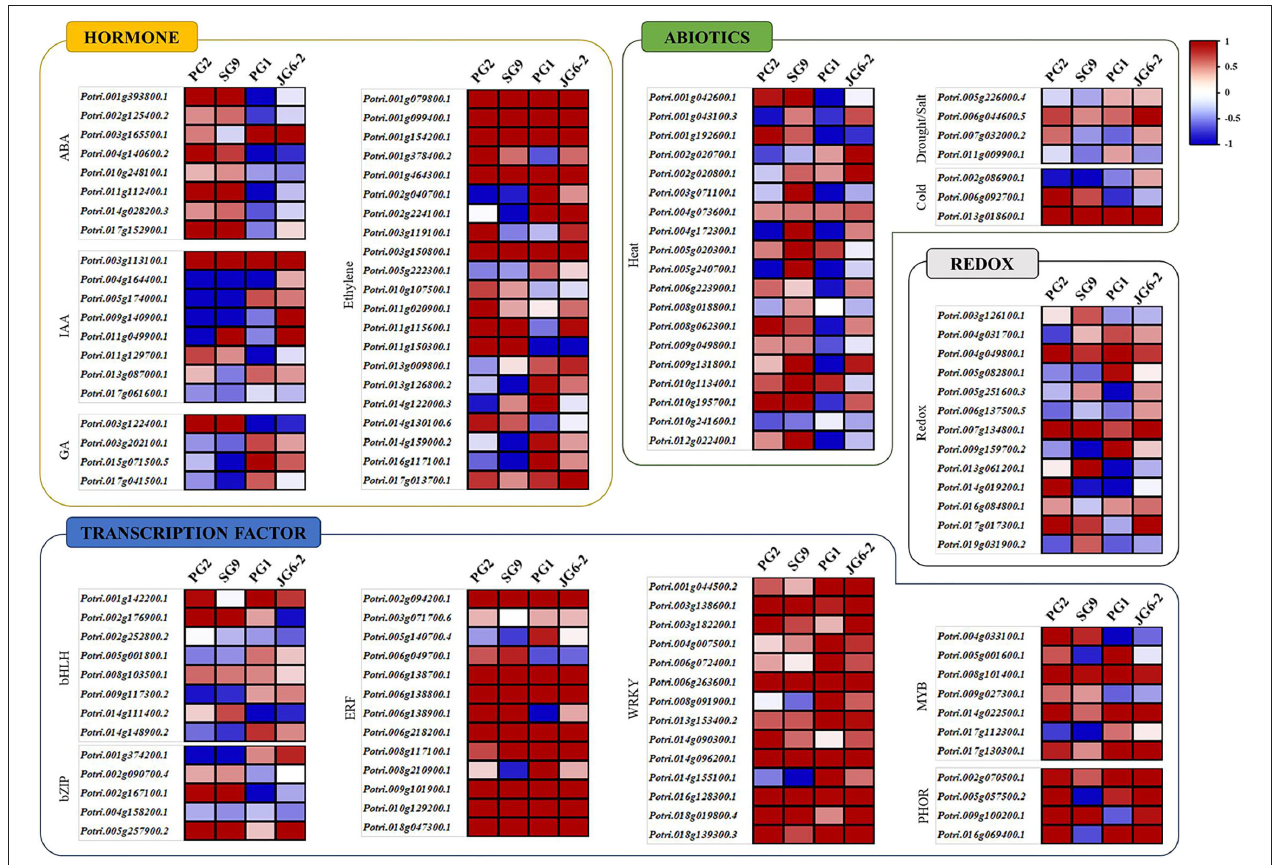
FIGURE 4 | MapMan analysis of dehydration-responsive P. davidiana DEGs. Differentially expressed genes with statistically significant and at least two-fold change in expression following the treatment were analyzed using MapMan. Results showed DEGs involved in abiotic stress responses, heat stress regulation, signaling of developmental hormones such as IAA, ABA, Ethylene, GA and defense hormones JA and SA, redox regulation, and those encoding important transcription factors such as WRKY, ERF, bZIP, MYB, and